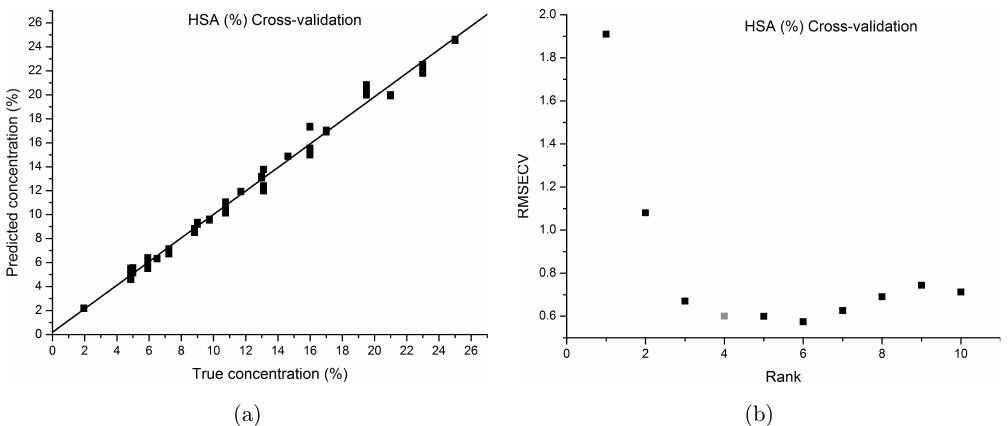
Fig. 4. Cross-validation results of the PLS model: (a) predicted concentrations vs actual concentrations; (b) minimum RMSWCV is 0.64 in the fourth rank.